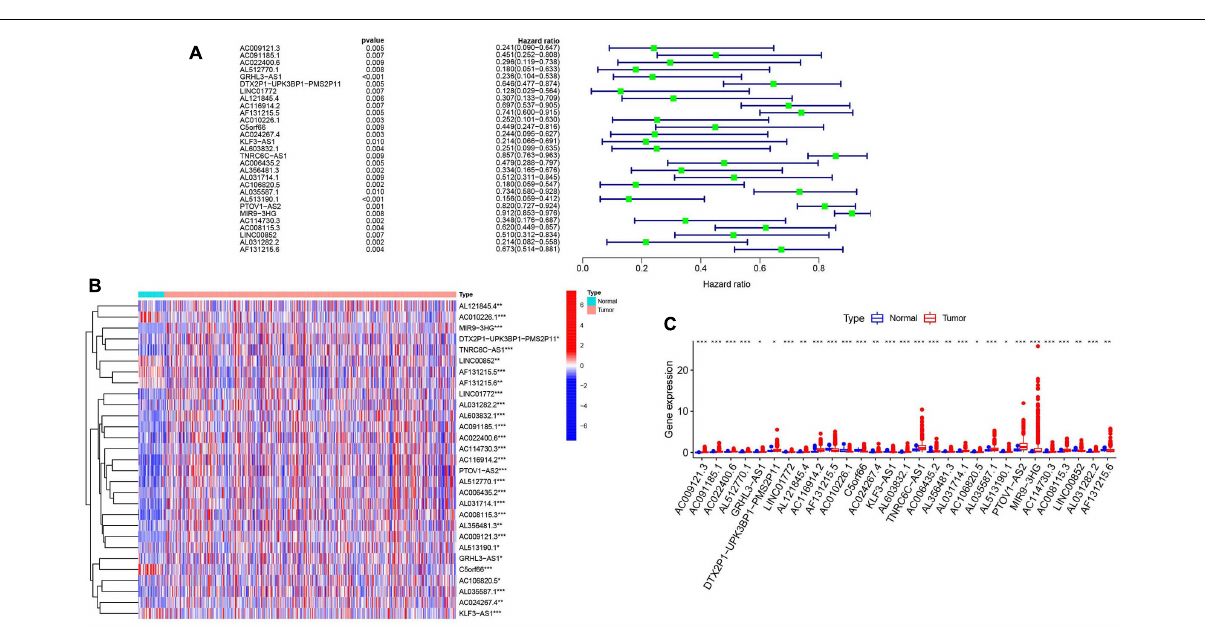
FIGURE 3 | m 6 A RNA methylation-related IncRNAs regulators in HNSCC in TCGA cohort. (A) Univariate Cox regression was performed to screen the signature in 29 m 6 A RNA methylation-related IncRNAs. (B) Heatmap presented the overall expression of 29 m 6 A RNA methylation-related IncRNAs in HNSCC tissues and normal tissues from The Cancer Genome Atlas (TCGA) datasets. P < 0.05 ("*"), P < 0.01 ("**"), and P < 0.001 ("***"). (C) The differential expression of the m 6 A RNA methylation-related IncRNAs was visualized by boxplot (blue means normal tissues; red means HNSCC